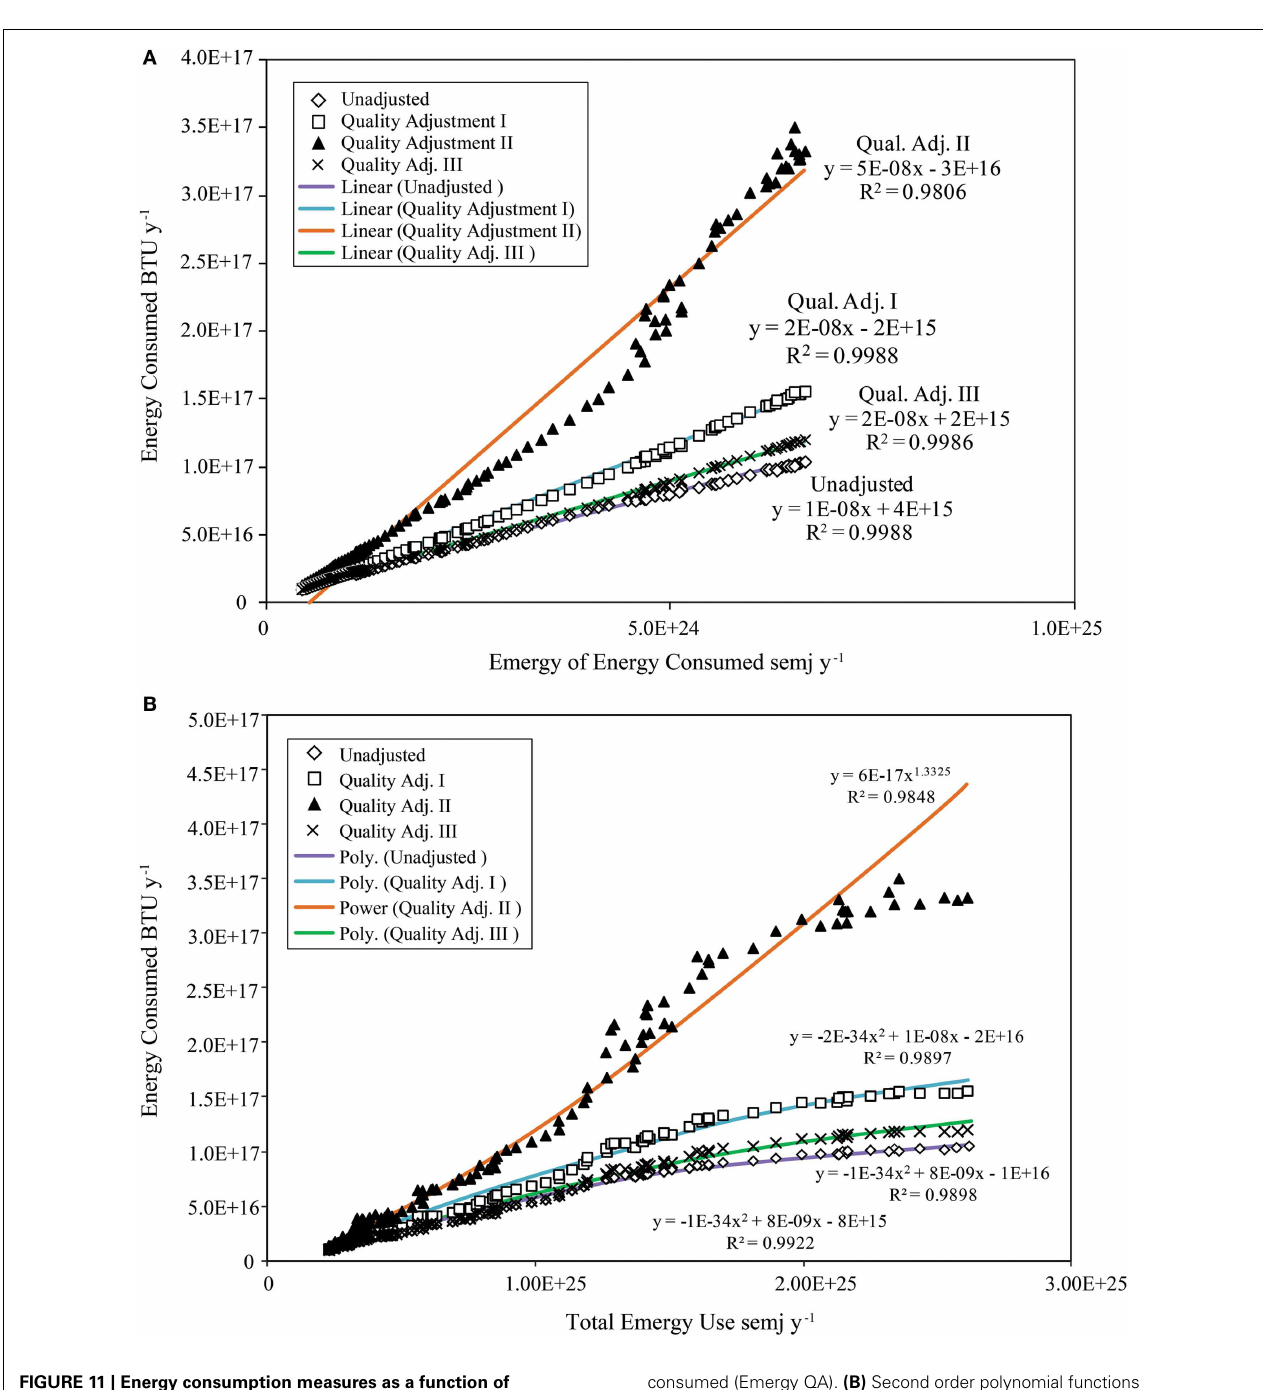
FIGURE 11 | Energy consumption measures as a function of emergy measures . (A) Strong linear relationships were found between the three measures of QA energy consumption and unadjusted energy consumption with the emergy of the energy